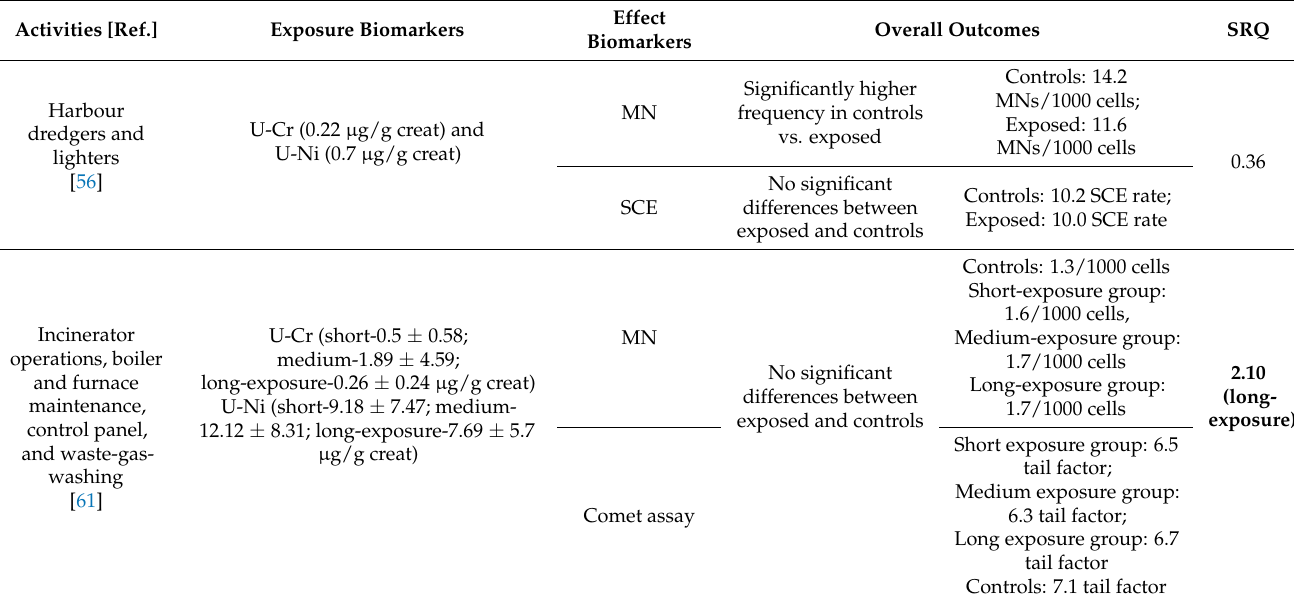
Table 6. Reported outcomes observed in biomarkers of